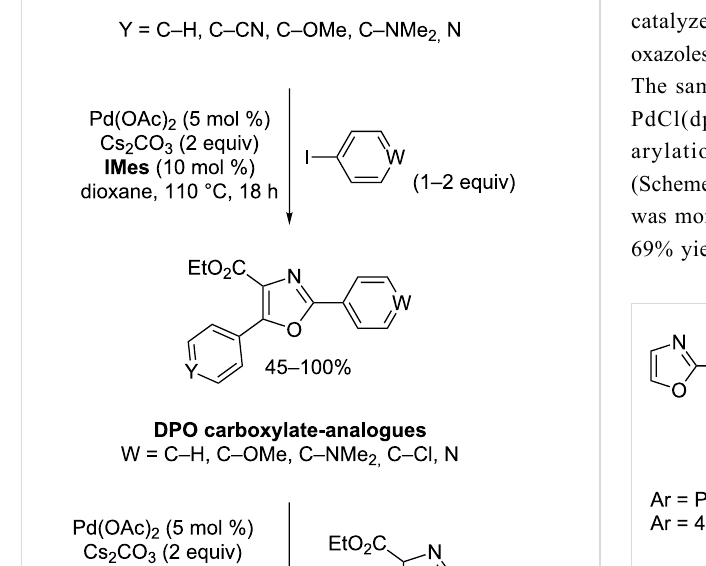
Scheme 12: Pd(0)-catalyzed direct arylation of benzoxazole with aryl chlorides [54].